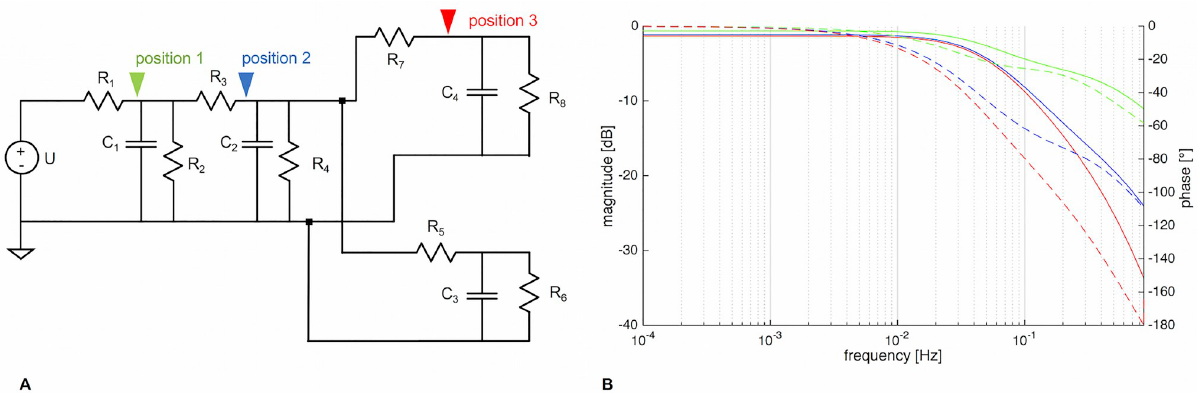
Fig 13. LTSpice schematic and resulting Bode plot of four three-element Windkessel. A) LTSpice schematic of four cascaded 3WK elements. U = voltage source, R = resistor, C = capacitor. B) Bode plots obtained at positions 1 (green), 2 (blue), and 3 (red). The more segments are added, the steeper does the filter cutoff become. Solid lines = magnitude [dB], dashed lines = phase [˚].